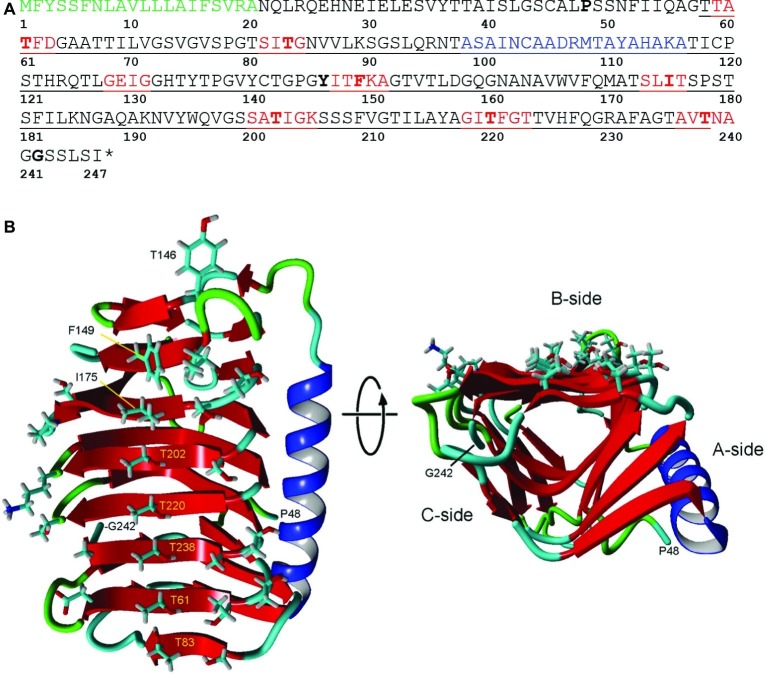
Structure of IBP1 of K. austriaca. (A) Deduced amino acid sequence. The protein has an N-terminal signal peptide (green) that is normally cleaved off as the protein is secreted from the cell and a DUF3494 ice-binding domain (underlined). Additional features predicted by Swiss Model/Yasara, see (B), include beta sheets (red) that make up the ice-binding site and an α-helix (blue) that is characteristic of DUF3494 domains. Key residues that may be involved in ice binding, and the N- and C-terminal residues in the model are shown in bold. * stop codon. (B) Two views of the predicted structure of the DUF3494 domain based on the structure of efcIBP. This domain has the form of a triangular beta solenoid with sides A, B, and C, in which the B side is the predicted ice-binding site. Left, front view of the B side. Key residues in (A) are labeled. Right, view along the axis of the beta solenoid with the B side at top. Color coding is same as in (A).